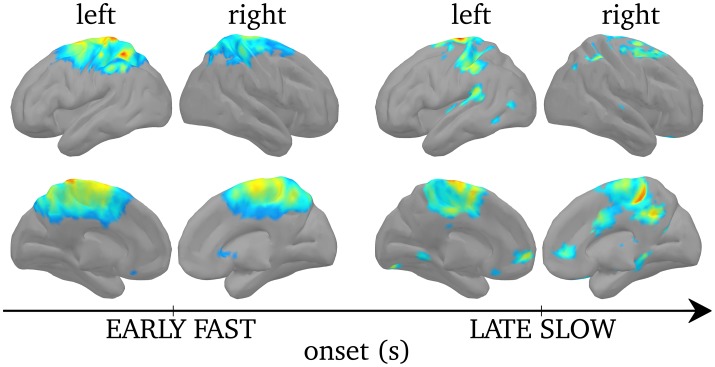
Non-parametric statistical threshold on activation maps for the early fast SEs (left) and the late slow SEs (right). Upper rows displays cortices from a lateral view while lower row displays cortices from a medial view. Non-parametric statistical threshold was set to 0.05, Bonferroni-corrected. Color code here indicates the group-level average F-value (see Section Power of Synchronous Sources) of the significantly activated sources, insignificant ones are set to 0.